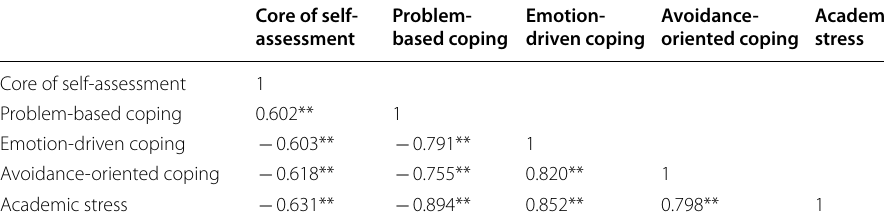
Correlation is significant at the 0.01 level (2‑tailed)